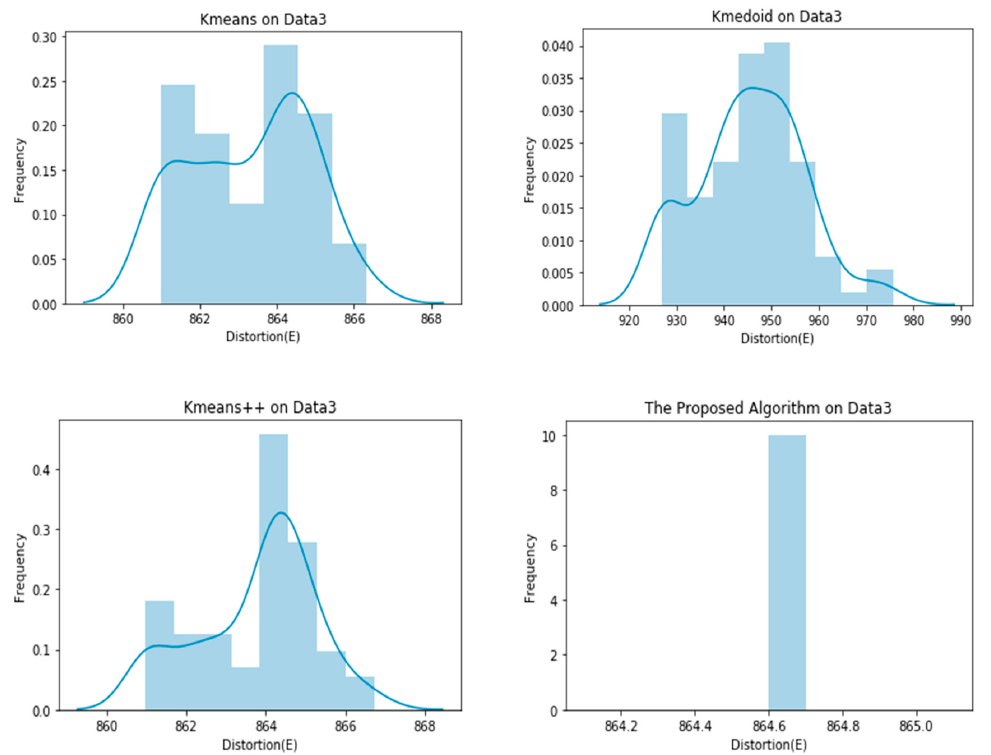
ff erent algorithms on